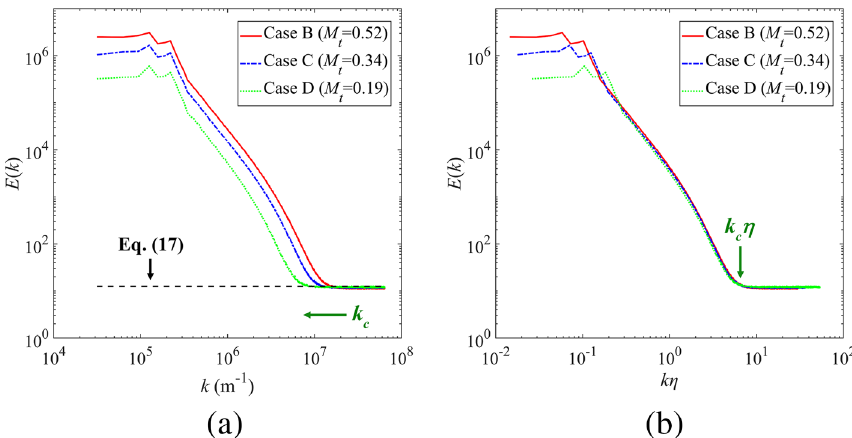
Fig. 4 The energy spectra of 1D compressible turbulence in the B, C and D cases. The abscissa of panel (a) is the wavenumber, and the abscissa of panel (b) is the wavenumber multiplied by the Kolmogorov length scale. The spectrum of thermal fluctuations calculated from Eq. (17) is also shown in panel (a) for